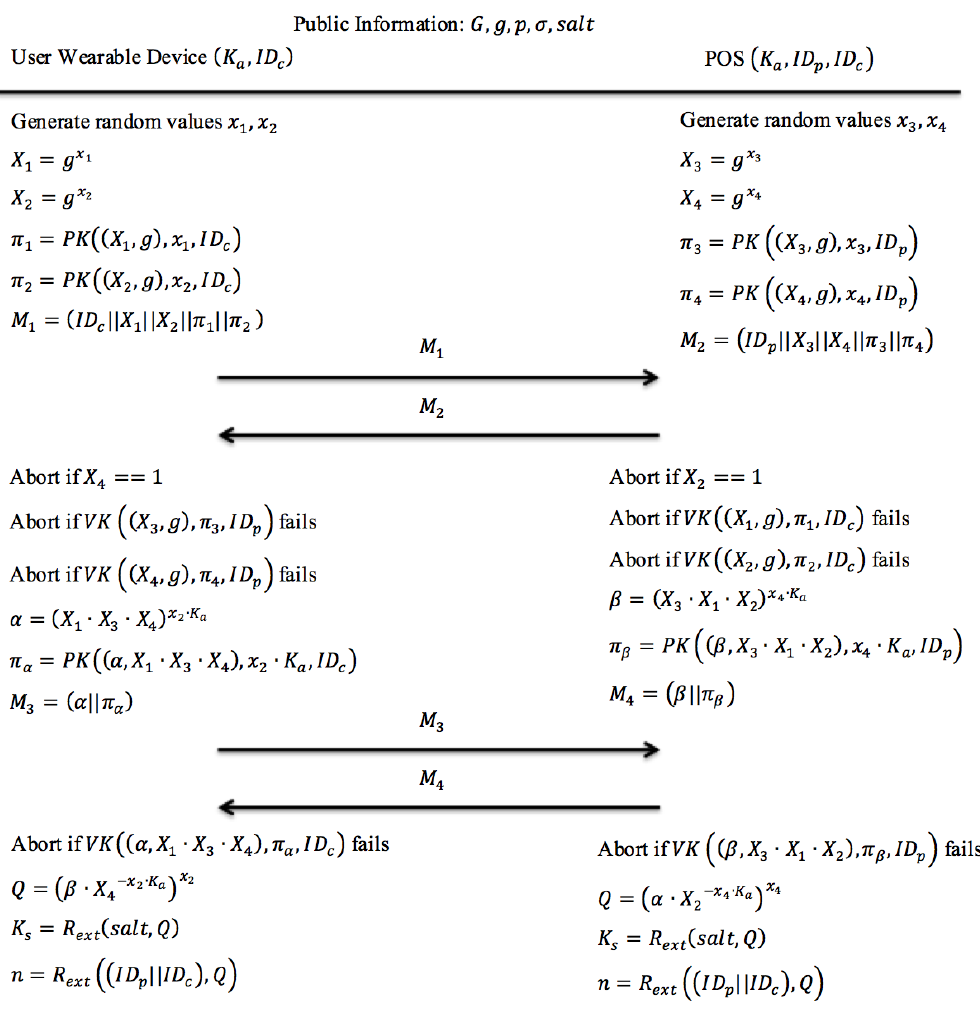
Figure 4. The proposed protocol design for the session key construction phase.